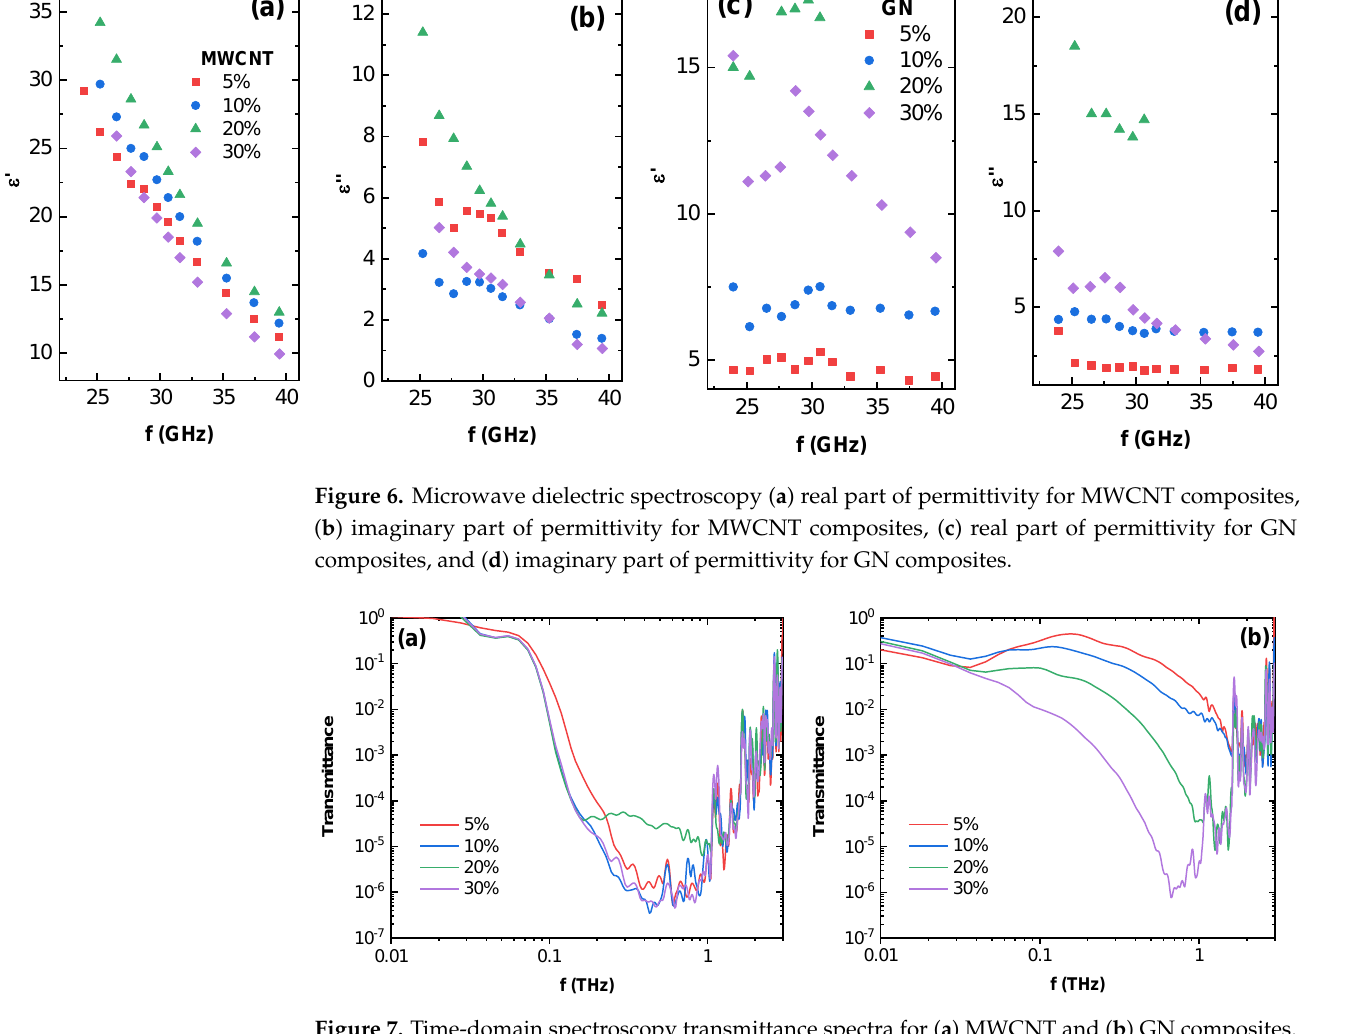
Figure 7. Time − domain spectroscopy transmittance spectra for ( a ) MWCNT and ( b ) GN compo- Figure 7. Time-domain spectroscopy transmittance spectra for ( a ) MWCNT and ( b ) GN sites.